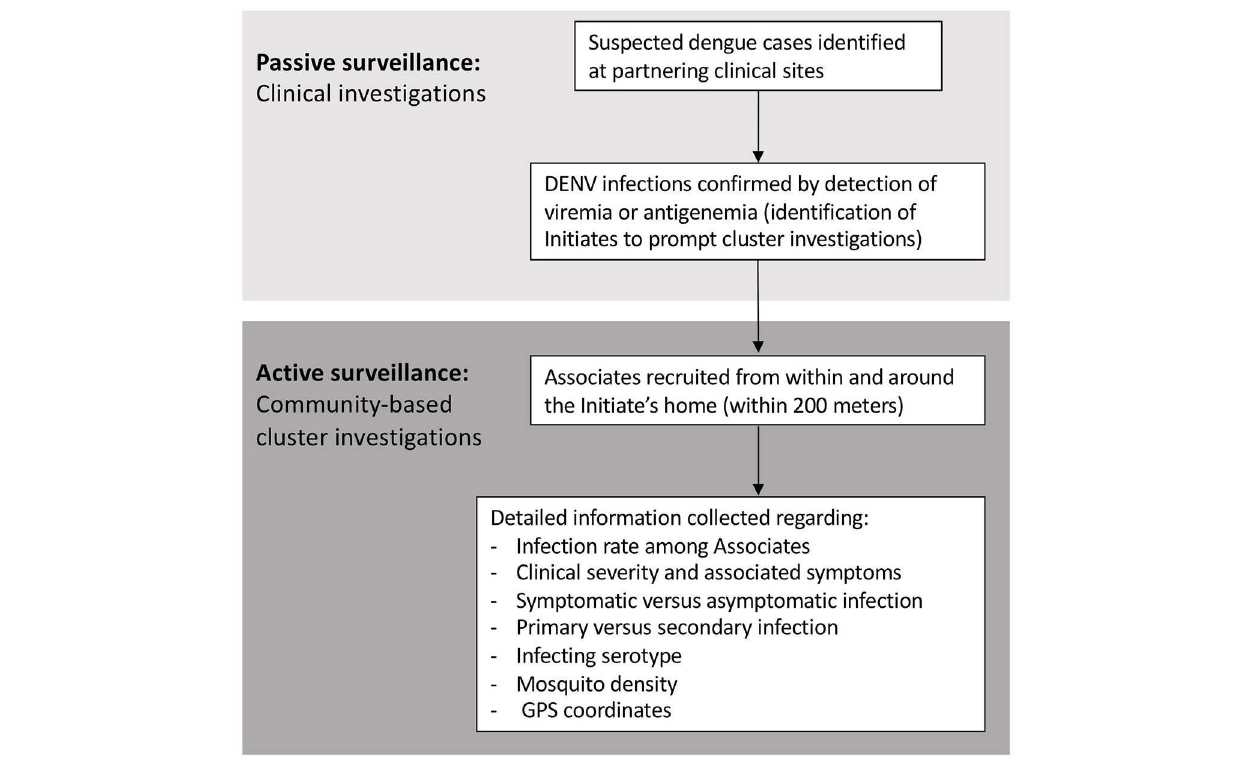
FIGURE 1 | Summary of study activities for the Thai and Ecuadorian studies.